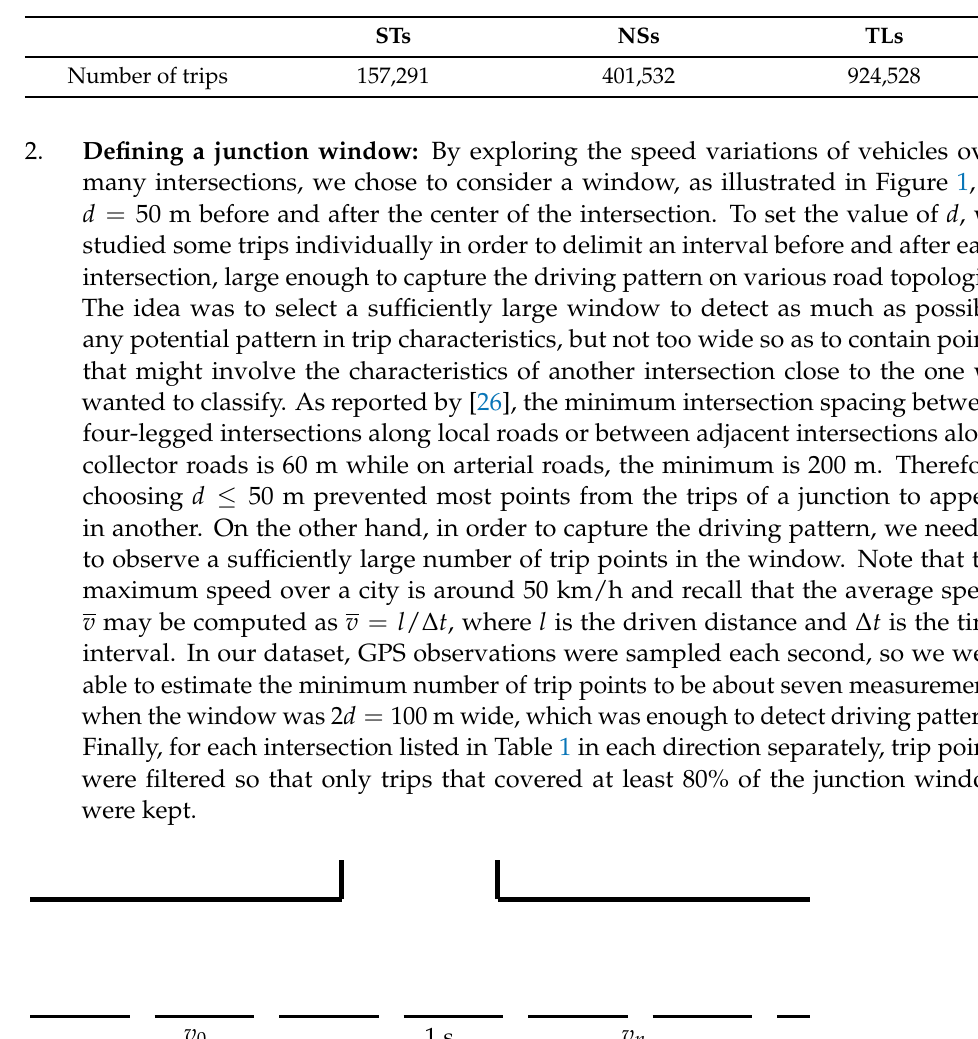
Table 2. Trip count per junction type.